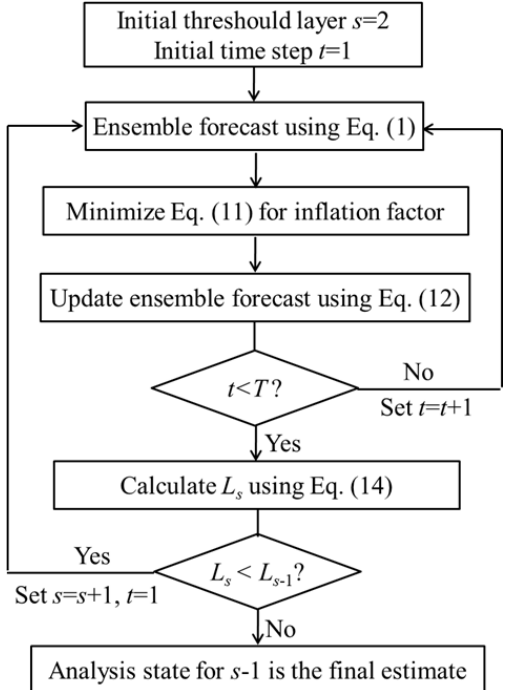
Figure 2. The assimilation procedure and localization scale factor estimation in the experiments. All of the equations are in accordance with that described in the